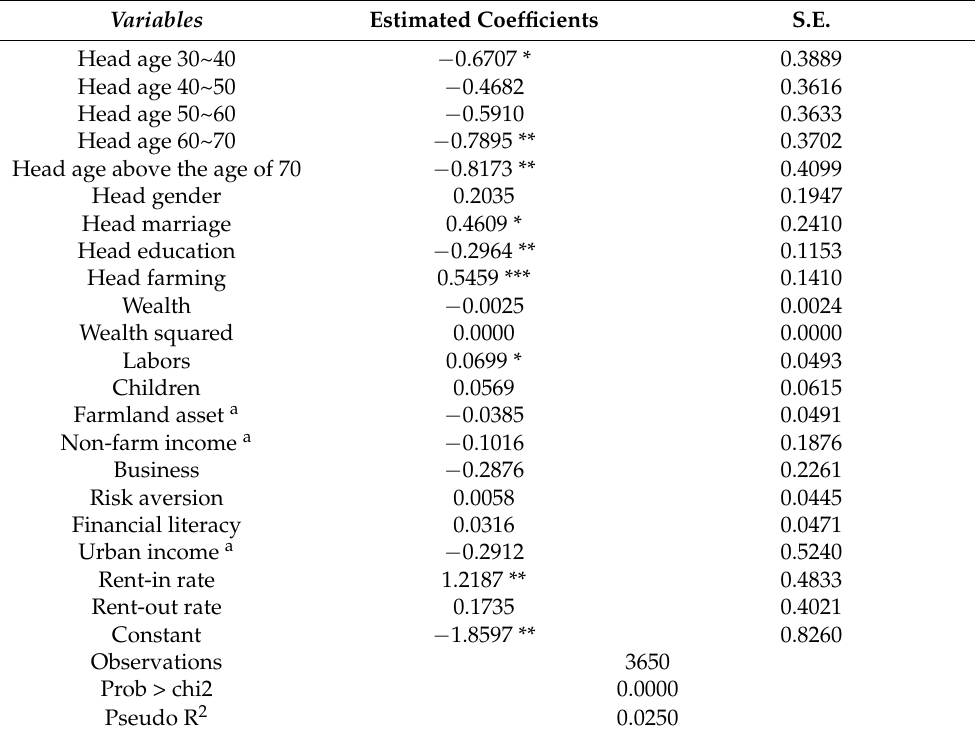
Table 3. Estimation results of the logit model of farmland tenancy participation